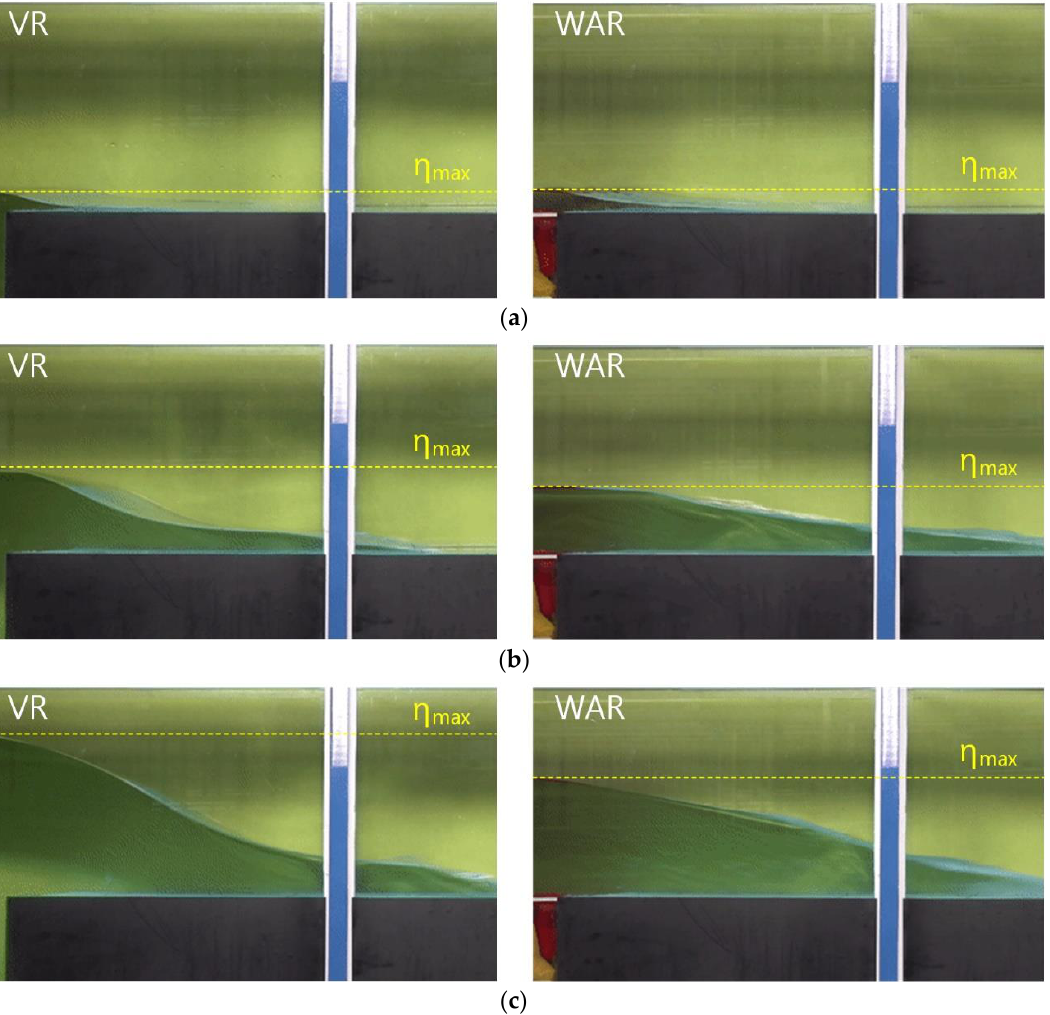
Figure 2. Images of solitary wave overtopping and inundation on the VR (left) and WAR (right): ( a ) Run-1 ( 𝐴 0 = 4.4 cm , 𝜀 = 0.09 ); ( b ) Run-7 ( 𝐴 0 = 12.3 cm , 𝜀 = 0.26 ); ( c ) Run-11 ( 𝐴 0 = 21.5 cm , 𝜀 = 0.46 ).